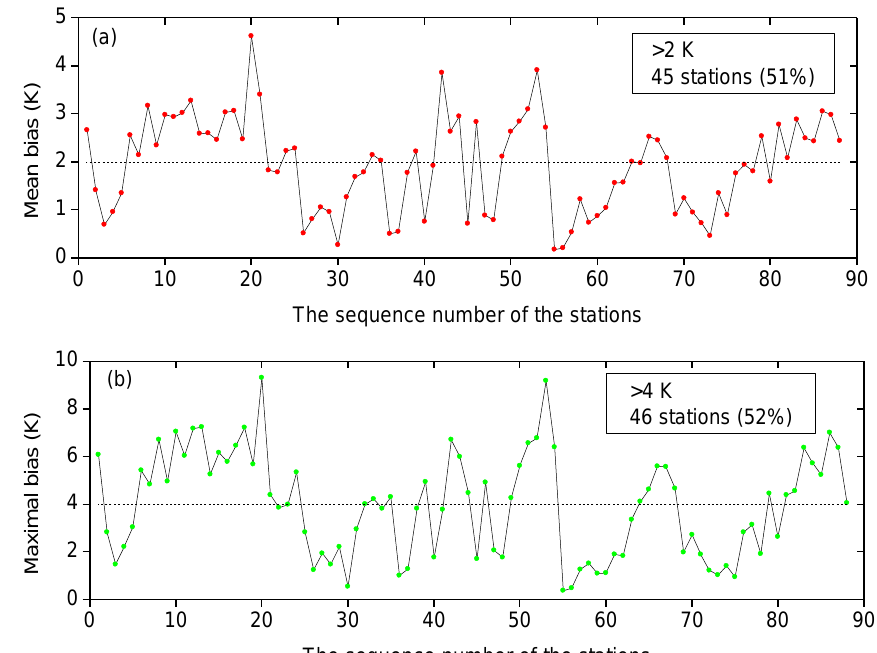
mean relative bias, or 1% maximal relative bias is chosen as the threshold.